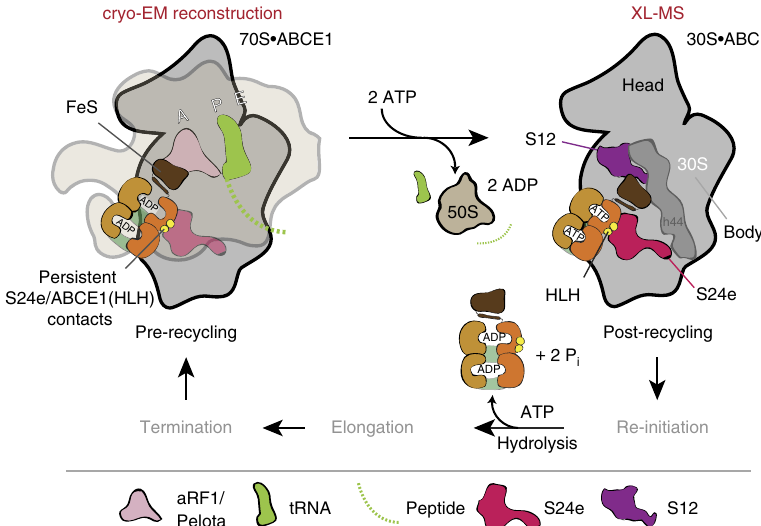
Figure 5 | Conformational changes of ABCE1 during ribosome recycling. During the cyclic process of translation, post-termination/pre-recycling complexes occur, which need to be recycled into their components to be available for the subsequent re-initiation. After e/aRF3 dissociation, ABCE1 binds to the GTPase binding site of these complexes, establishing contacts to the r-proteins of the large and small subunit (P0, L9, S24, S6) 8 . ATP occlusion of ABCE1 leads to major conformational changes, especially a large rotational and translational repositioning of the FeS cluster domain, which splits the ribosomal subunits apart—either directly or via the bound e/aRF1. ABCE1 itself remains bound to the small subunit until ATP is hydrolysed (PRC). Consequently, the contacts to proteins of the large subunit are released and major contacts to the proteins of the small subunit like S24e are preserved. Additionally, a new contact to the S12 protein is established, caused by the large rotational and translational movement of the FeS cluster domain, anchoring ABCE1 on the